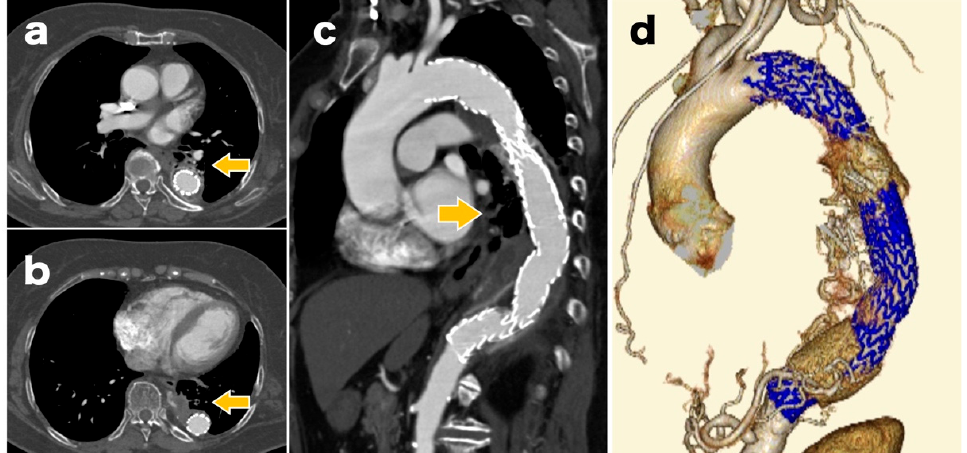
Figure 4. ( a , b , c ) Contrast-enhanced computed tomography at 12 months postoperatively shows infiltrative shadows in the lung fields around the graft and improvement of gaseous images (arrows). ( d ) No abnormality in the stent graft or endoleaks was observed.